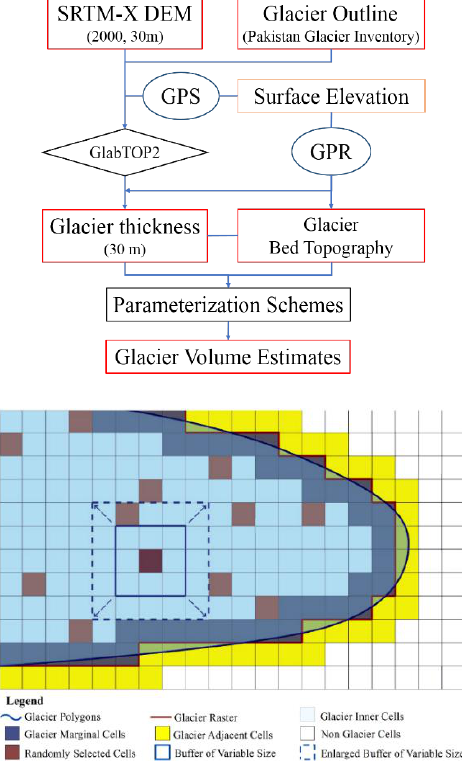
Figure 2. Data set and work flowchart for processing and schematic illustration of GlabTOP2 (Frey et al., 2014).